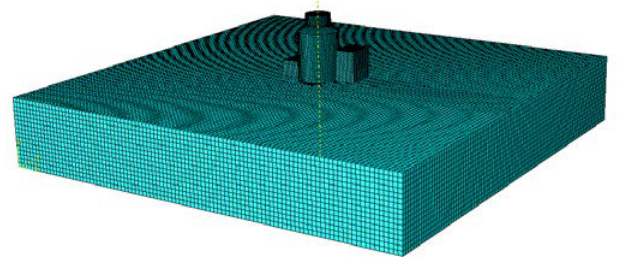
Figure 1. Finite element of the soil–structure